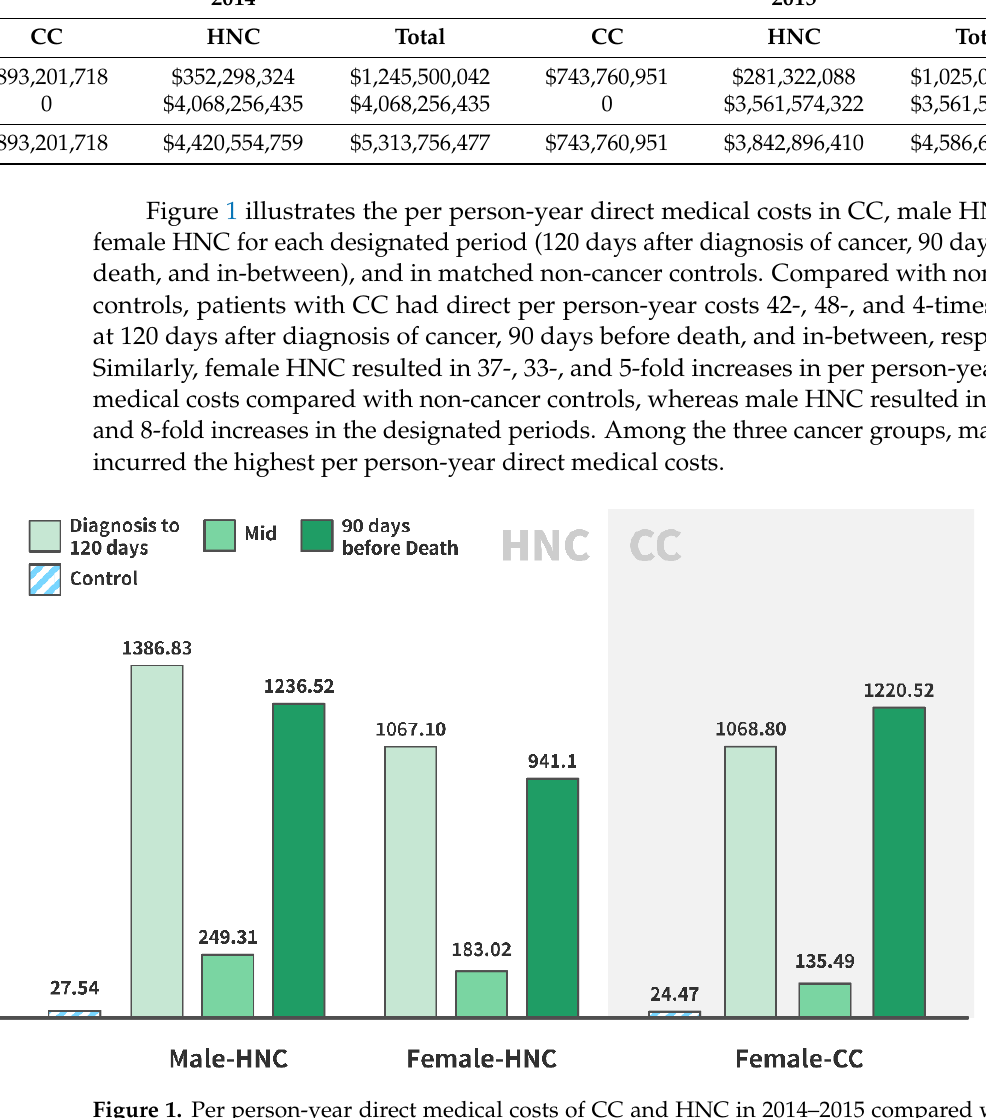
Figure 1. Per person-year direct medical costs of CC and HNC in 2014–2015 compared with non- cancer controls.